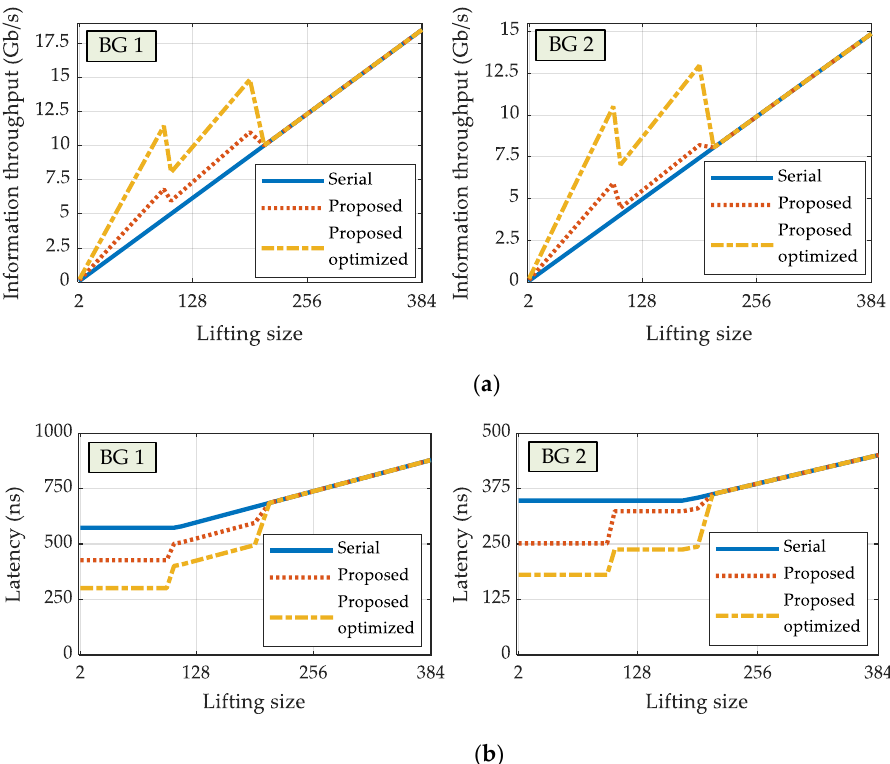
Figure 13. Performance of the proposed 5G NR LDPC encoder for three different encoding schedules and for various lifting sizes: ( a ) information throughput and ( b ) latency.